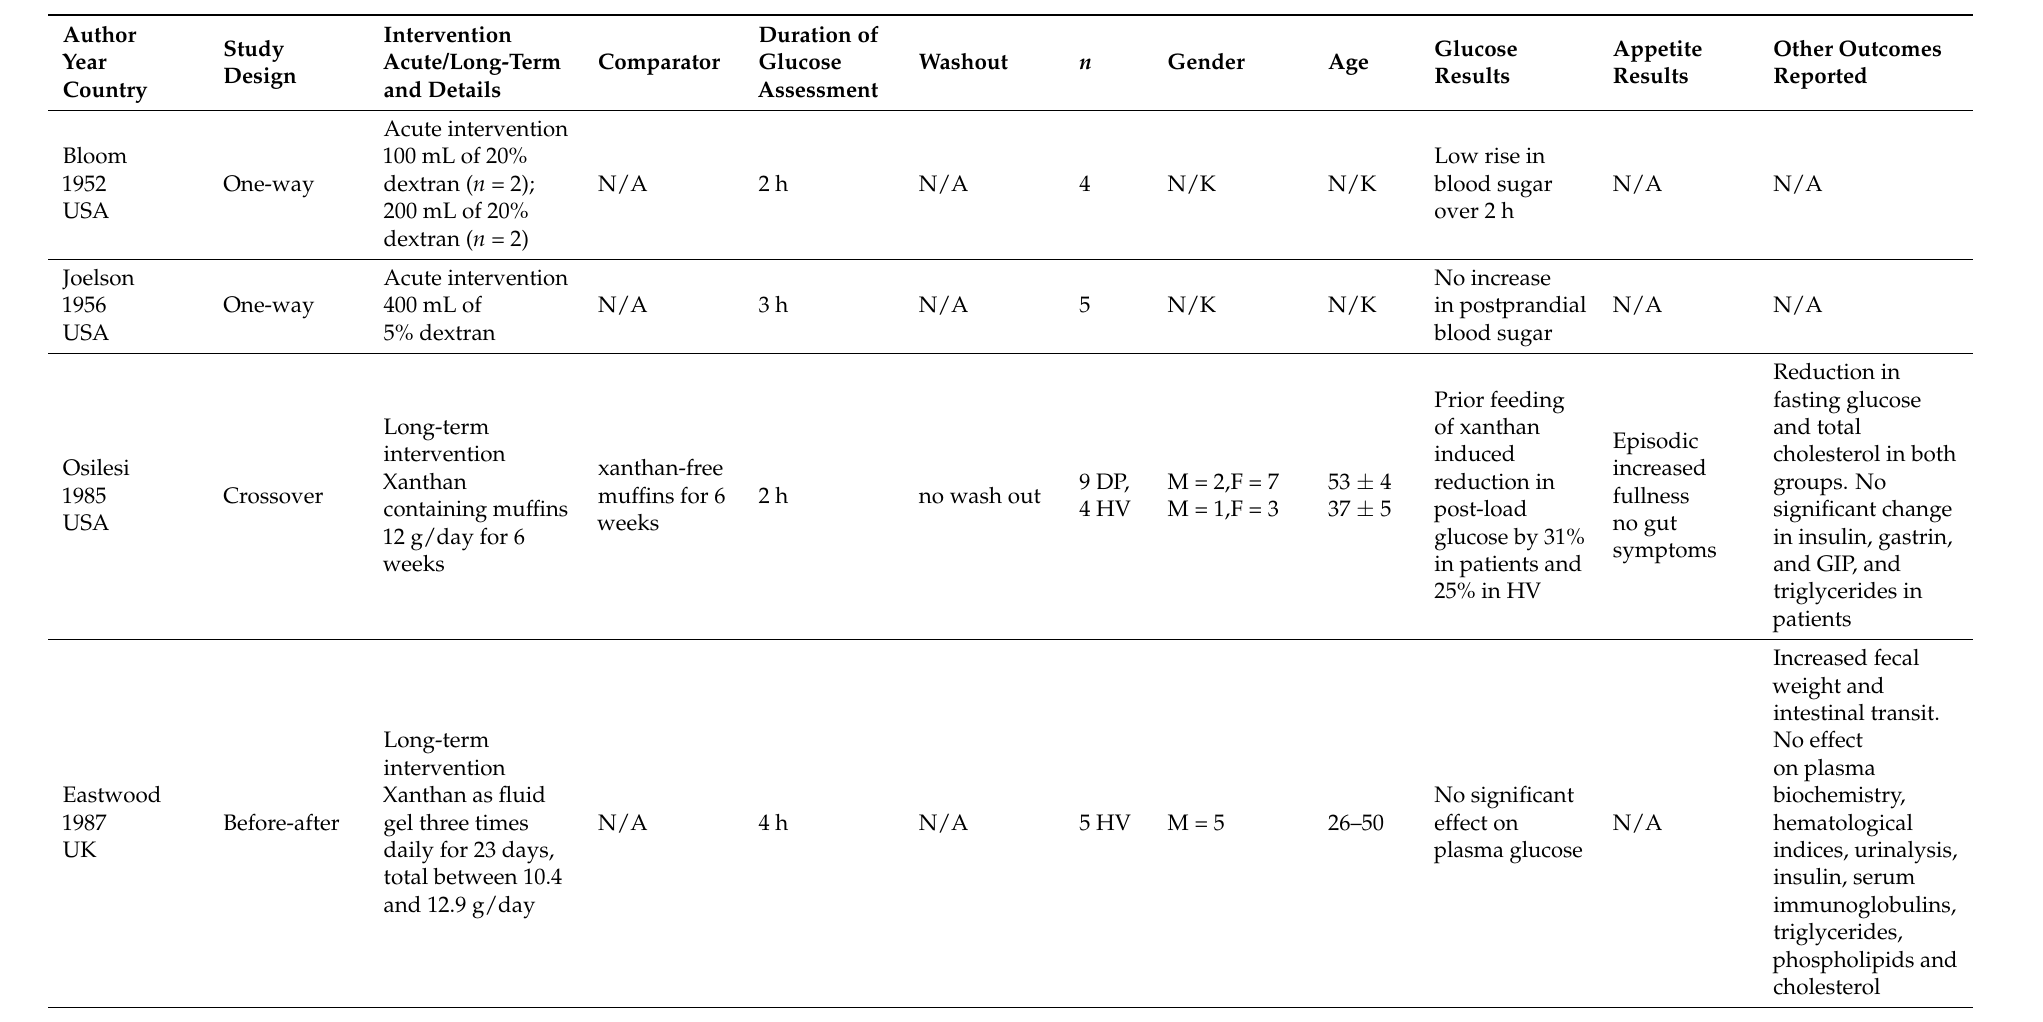
Table 1. Summary characteristics and results of the included